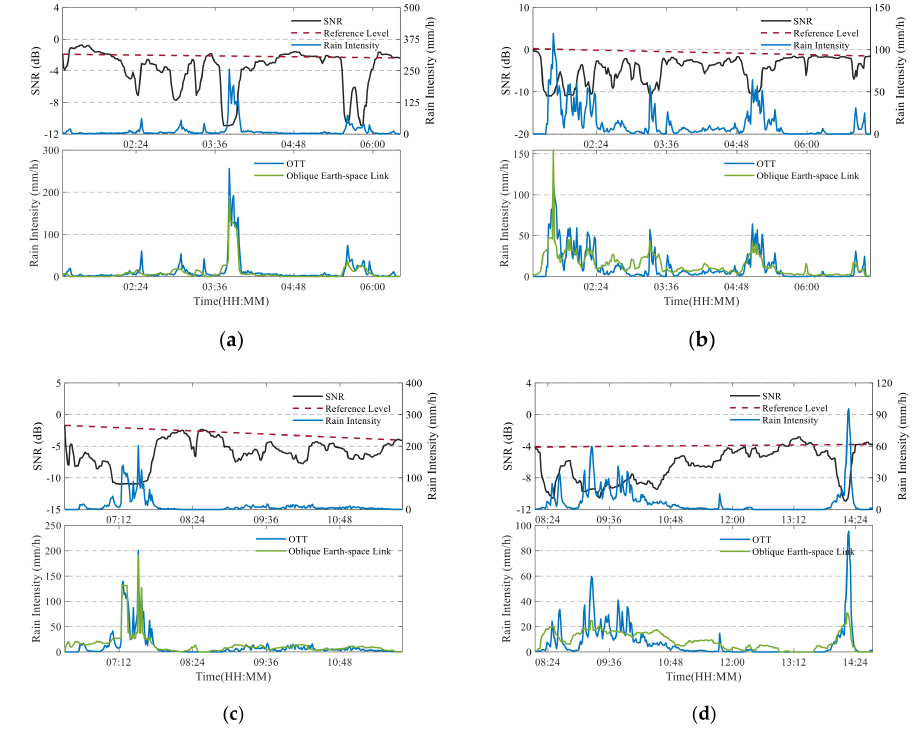
Figure 1. An extreme rainfall event occurred from June 13 to 16, 2020: ( a ) June 13, ( b ) June 14, ( c ) June, 15 and ( d ) June 16. The black line is the signal to noise ratio (SNR), the dark red dotted line is the reference level, the blue- and green line are the rain intensity measured by OTT-Parsivel (OTT) and earth-space links (OELs),